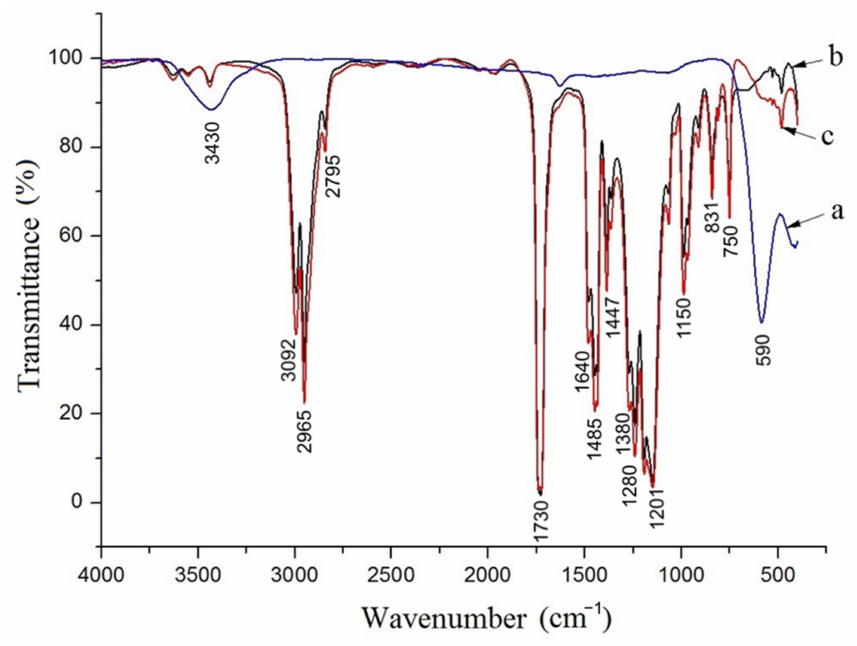
Figure 4. FT-IR spectra of: ( a ) NPs, ( b ) 5 wt.% NP composite, and ( c ) clear